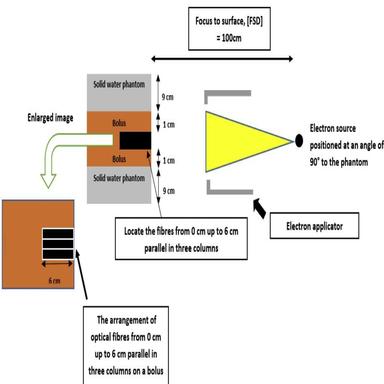
Schematic diagram of set-up for PDD experiment.